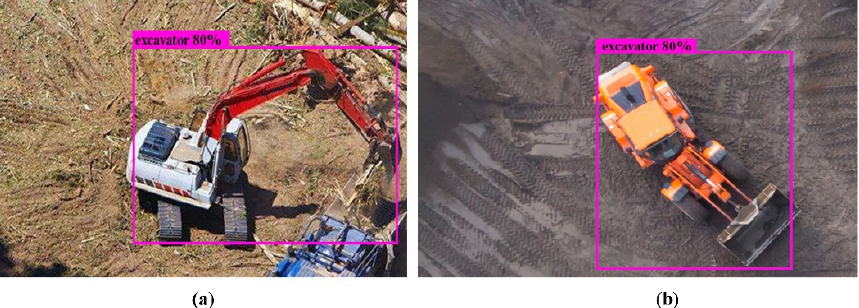
Figure 9. The images mistakenly detected as containing excavators. ( a ) Containing a grab machine; ( b ) containing a crane. ( b ) containing a